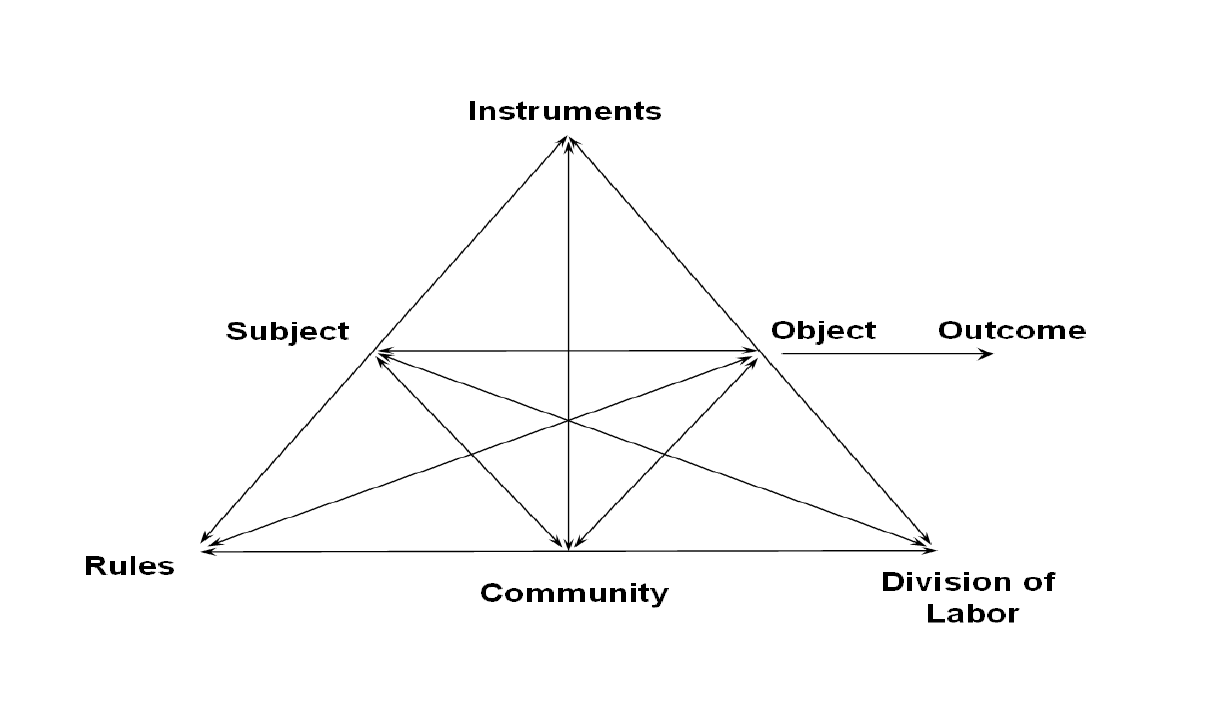
Figure 1 . A model of human activity proposed by Leont’ev (cited in Engeström, 2001, p.